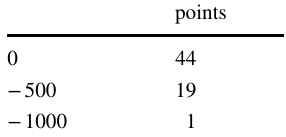
The difference in TDS observations